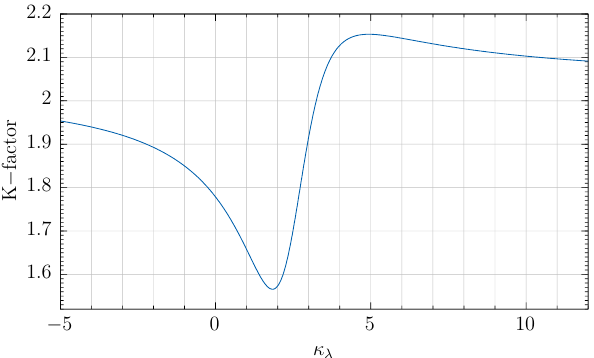
p s = 14 TeV. ; (cid:22) . The F R = m = 2, with 0 hh